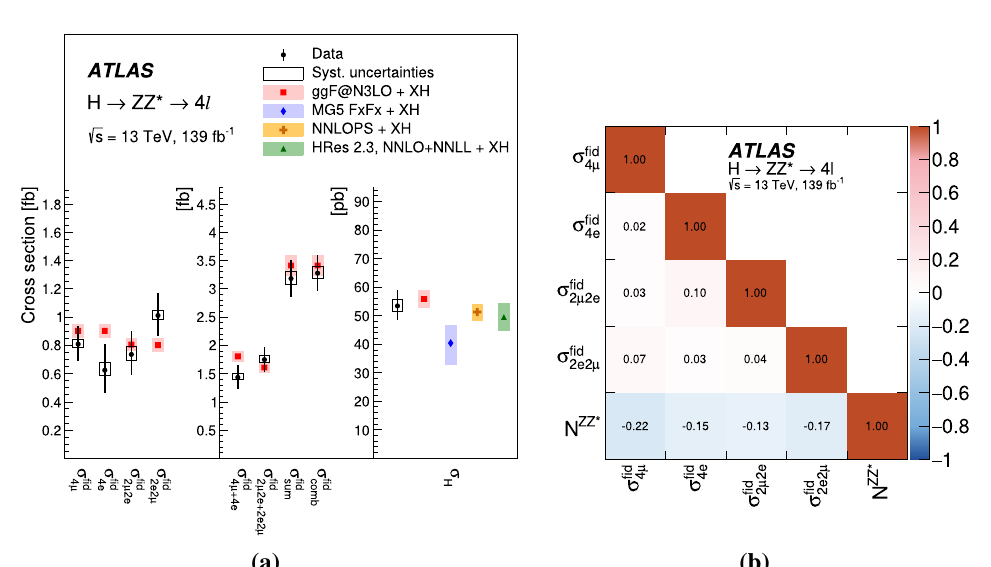
Fig. 18 a The fiducial cross sections (left two panels) and total cross section (right panel) of Higgs boson production measured in the 4 (cid:3) final state. The fiducial cross sections are shown separately for each decay final state, and for same- and different-flavour decays. The inclu- sive fiducial cross section is measured as the sum of all final states, as well as by combining the per-final-state measurements assuming SM Z Z ∗ → 4 (cid:3) relative branching ratios. The total SM prediction is accu- rate to N 3 LO in QCD for the ggF process. The cross sections for all other Higgs boson production modes XH are added. For the fiducial cross-section predictions, the SM cross sections are multiplied by the